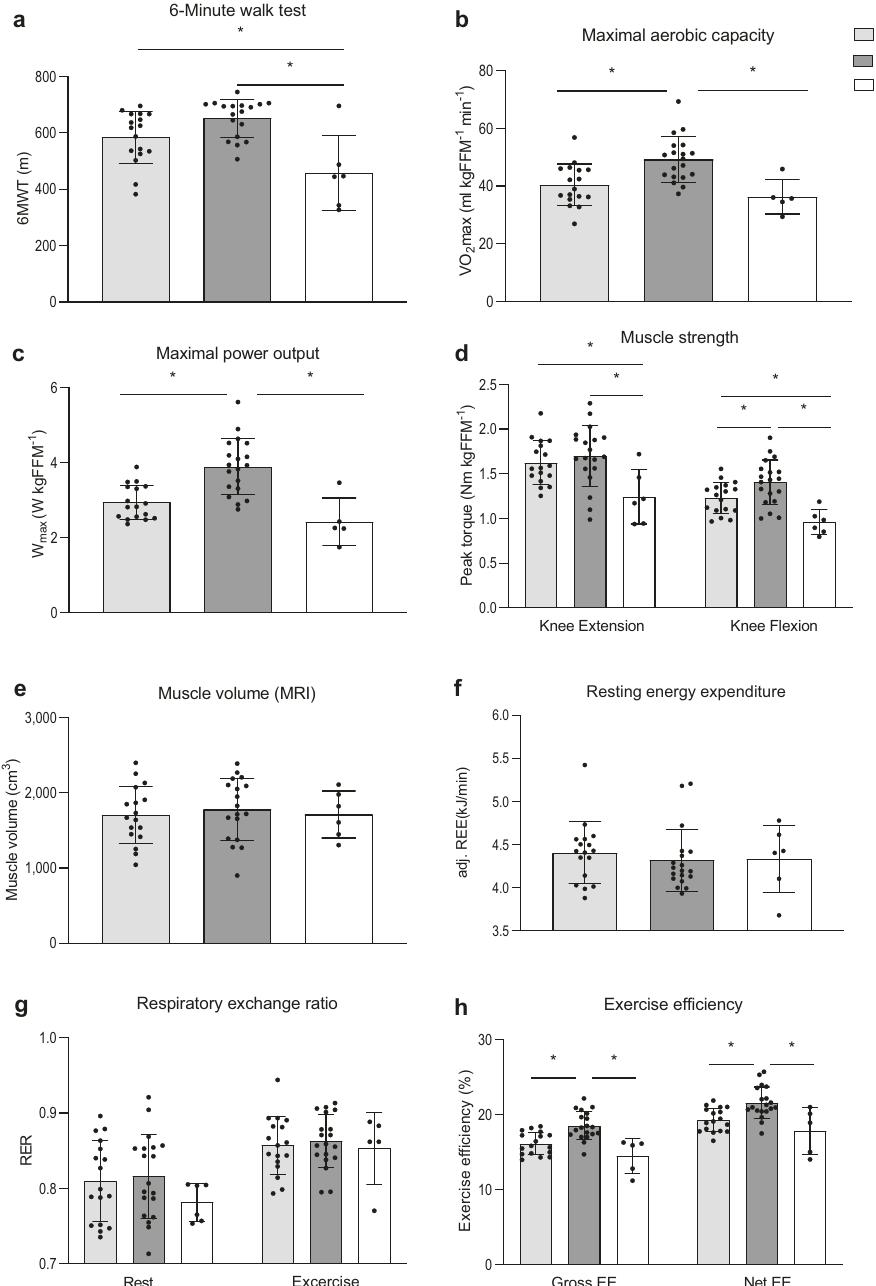
Fig. 4 Effect of exercise training and physical impairment on muscle health and exercise ef fi ciency in older adults. a Walking distance during the 6MWT performed on the Caren-system (O, n = 17; TO, n = 17; IO, n = 6). b Maximum rate of oxygen consumption measured during graded